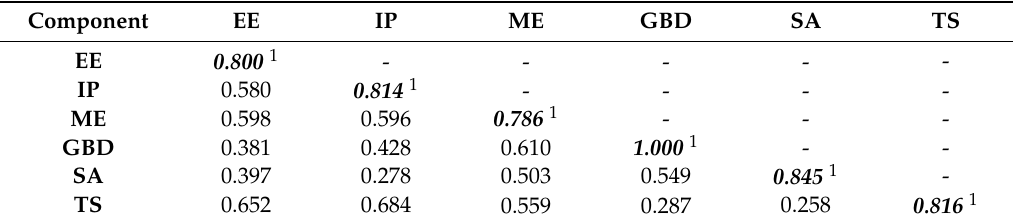
Table 7. Discriminant validity evaluation based on Fornell–Larcker